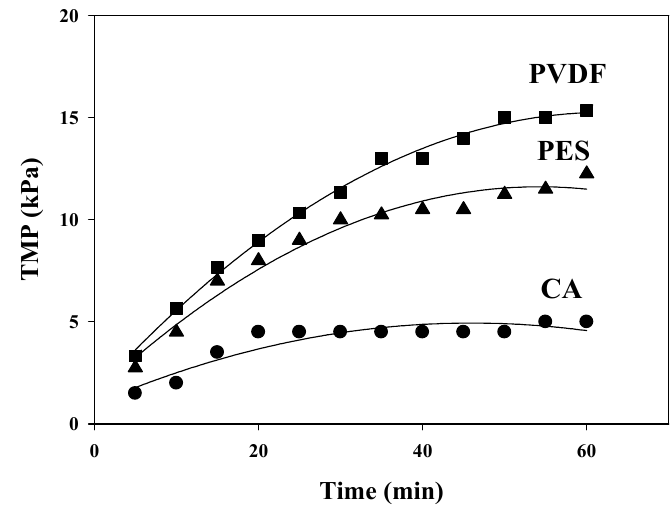
Figure 4. Transmembrane pressure (TMP) changes during batch filtration tests with activated sludge. The pore sizes of CA, PES and PVDF membranes were 30, 30, and 20 nm, respectively.